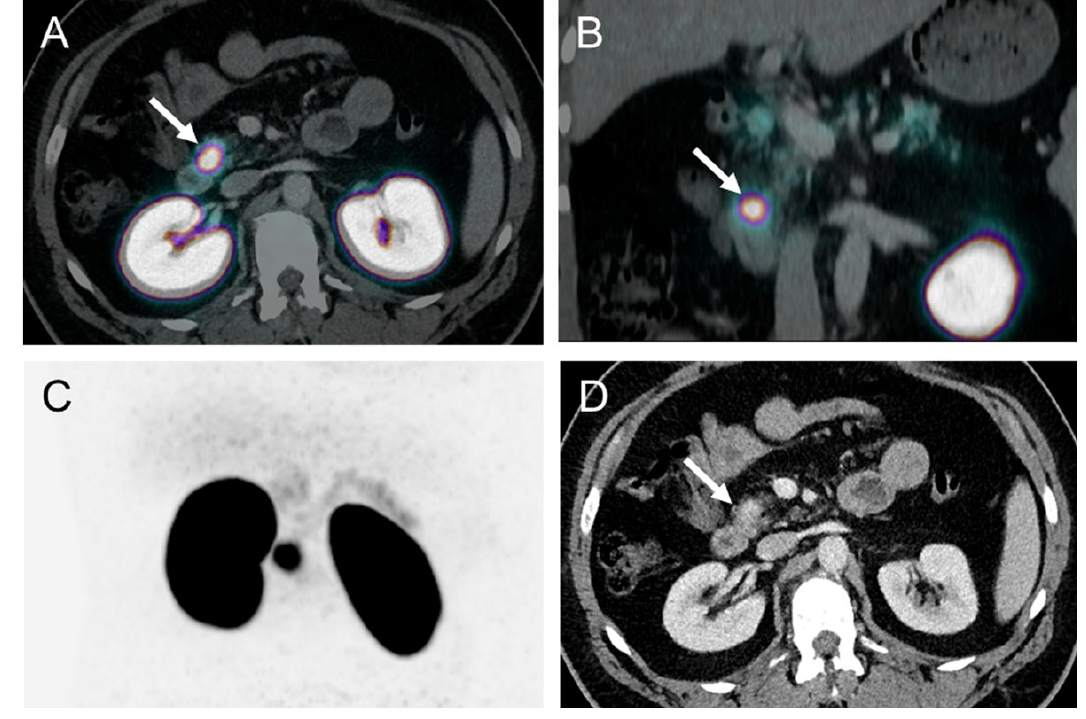
Figure 4: GLP-1 receptor targeting using 68 Ga-DOTA-exendin-4. Patient with endogenous hyperinsulinaemic hypoglycaemia without evi- dence of an insulinoma in the prior external scans.Transaxial (a), coronar (b) and MIP (c) of PET/CT 2.5 h after injection of 68